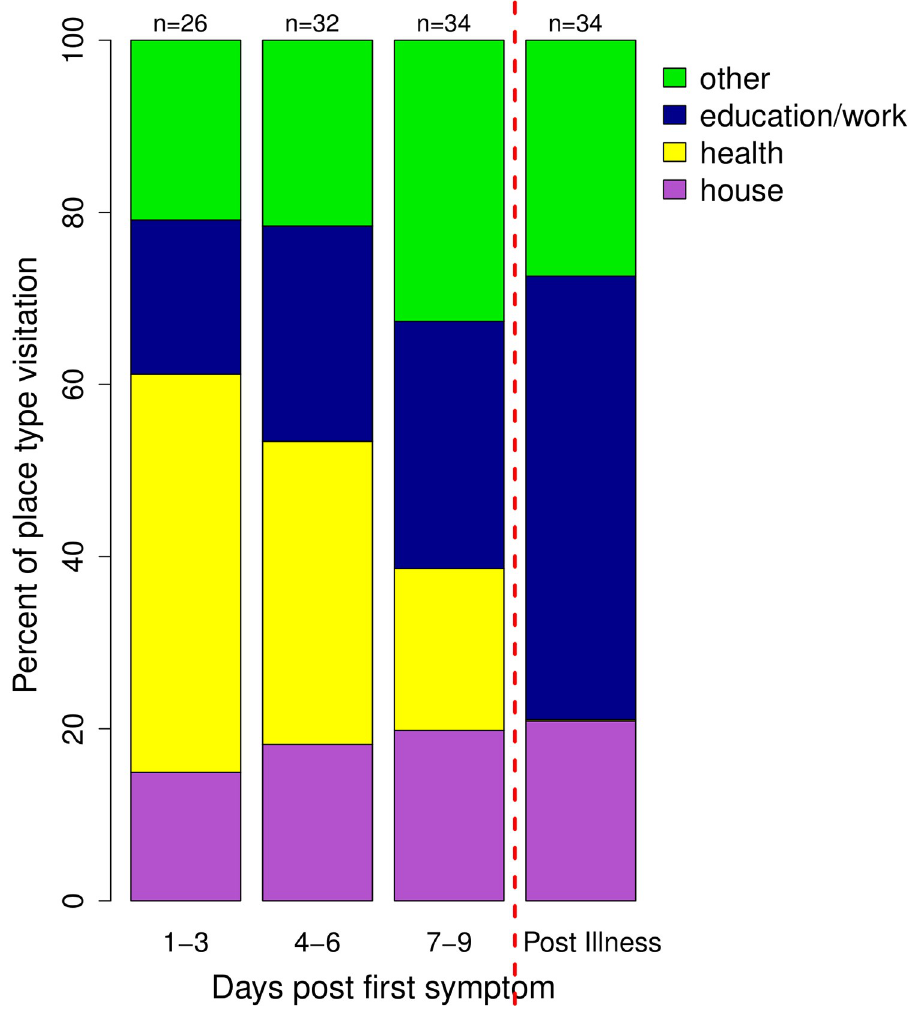
Fig 4. Place Types visited during illness (in 3-day intervals). Expressed as the percent of locations being visited of each location type. Other location type includes: markets, restaurants, ports, churches, cemeteries, recreational places, internet cafes, and all else. The number of participants who visited places is listed above each time